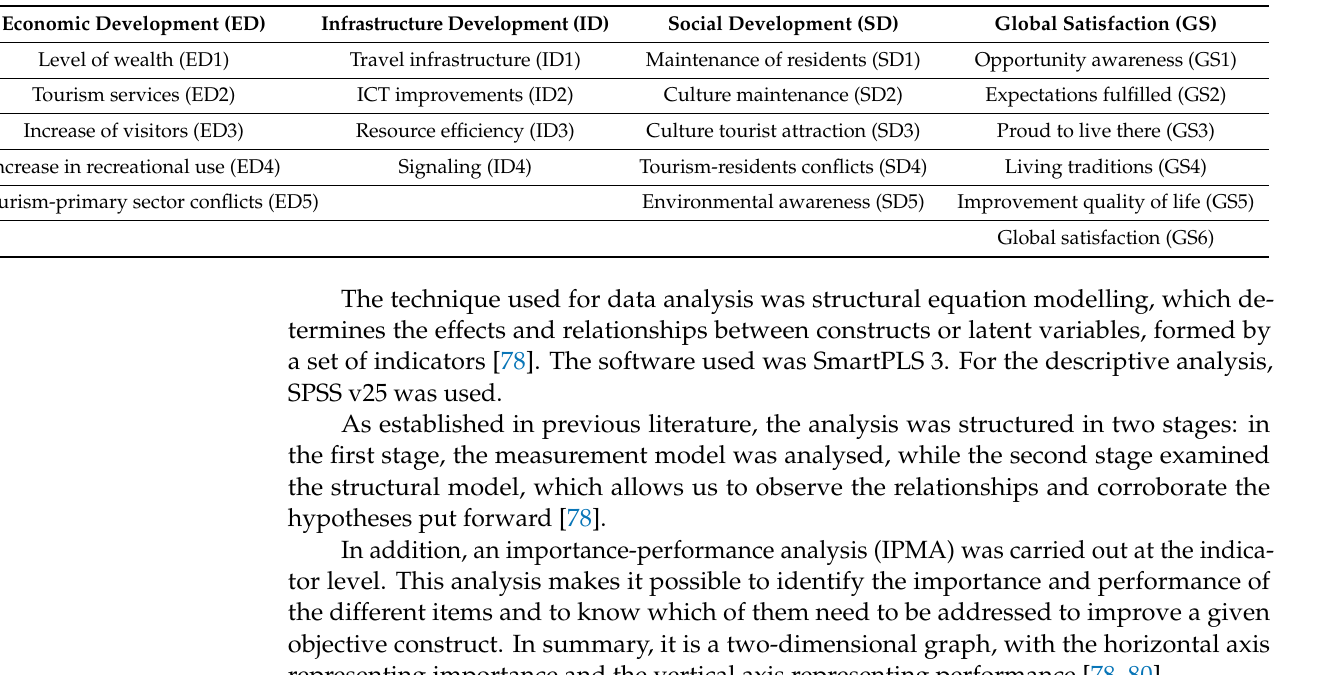
Table 2. Latent variables and indicators.